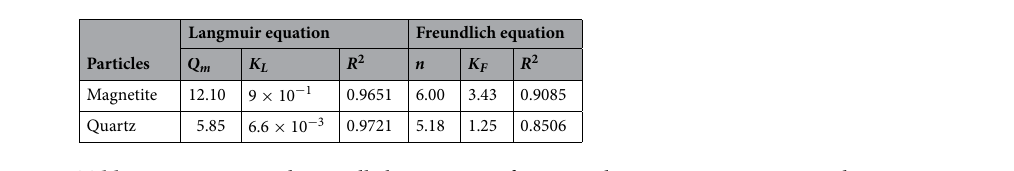
Table 4. Langmuir and Freundlich parameters for PGA adsorption on magnetite and quartz.